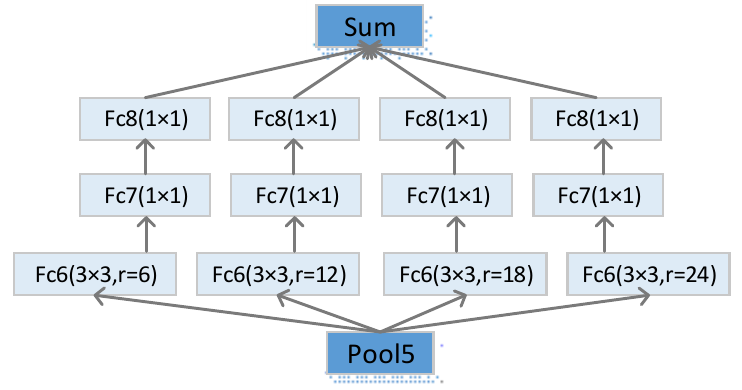
Figure 3. Illustration of ASPP with different atrous rates in each brunch. Atrous convolution provides different sizes of the field of view using different sam- pling rates and ASPP captures the local features of the tongue boundary in a small field of view. These two operations can find the optimal trade-off between accurate localization and context assimilation. Hence, the combination of the two operations can recognize the tongue boundary precisely and segment tongues of different sizes